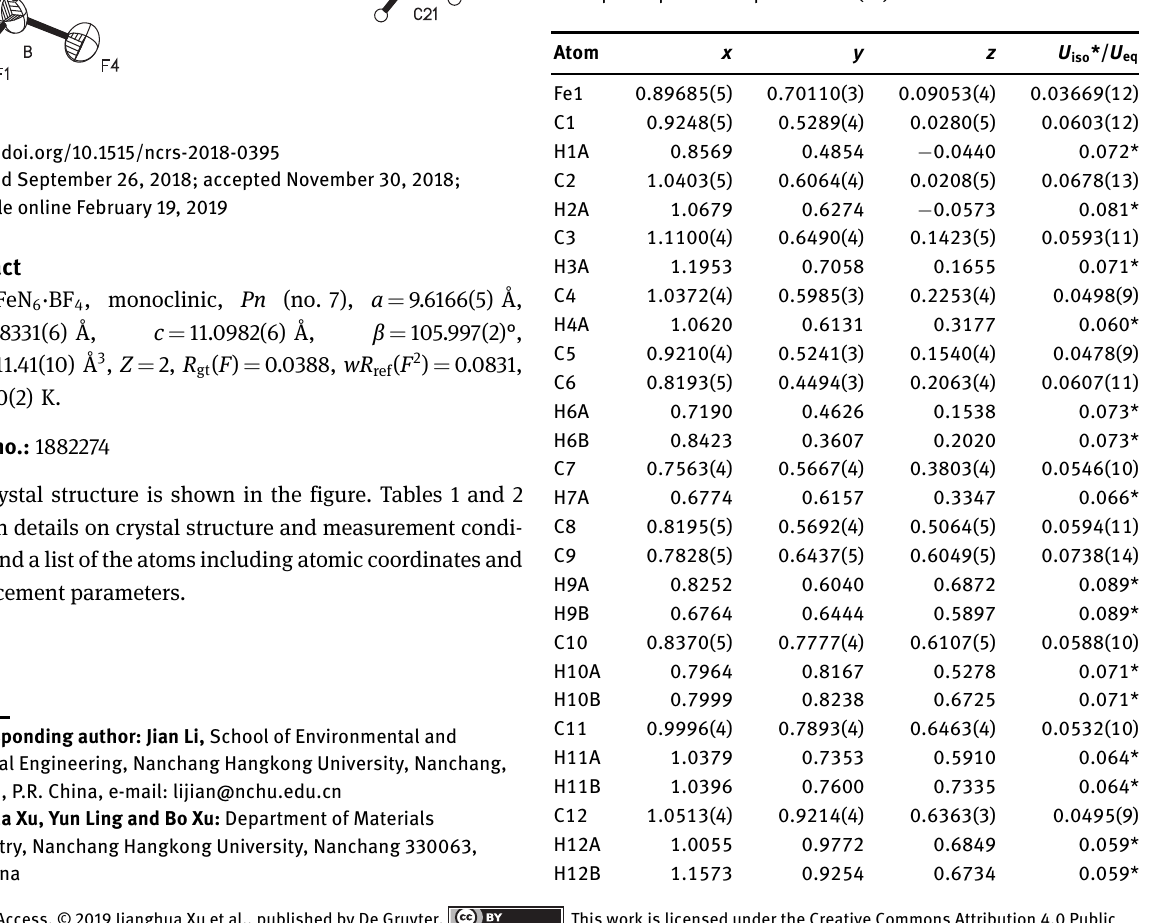
Table 2: Fractional atomic coordinates and isotropic or equivalent isotropic displacement parameters (Å 2